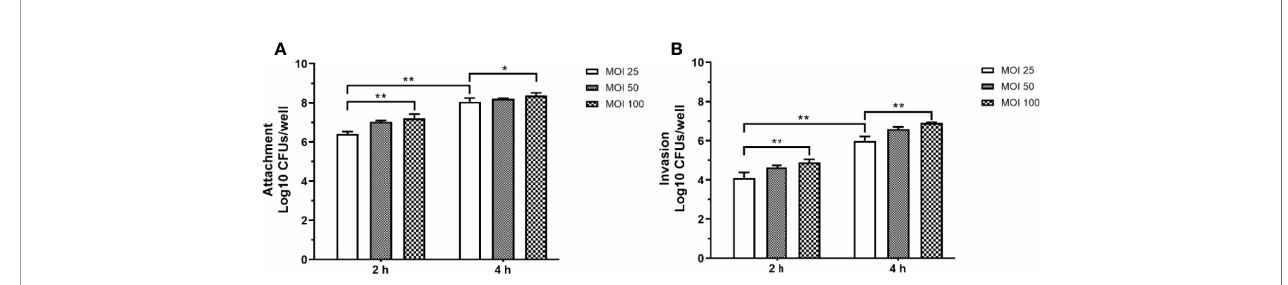
FIGURE 2 | The adhesion (A) and invasion (B) of P. aeruginosa infected RAW264.7 cells with different MOI (10, 50, 100). The extracellular or intracellular bacteria were counted by plate. For the invasion assay, extracellular bacteria were killed with 200 m g/mL gentamicin. All data were expressed as means ± SD (n=3). *P < 0.05, ** P < 0.01 vs the control group.